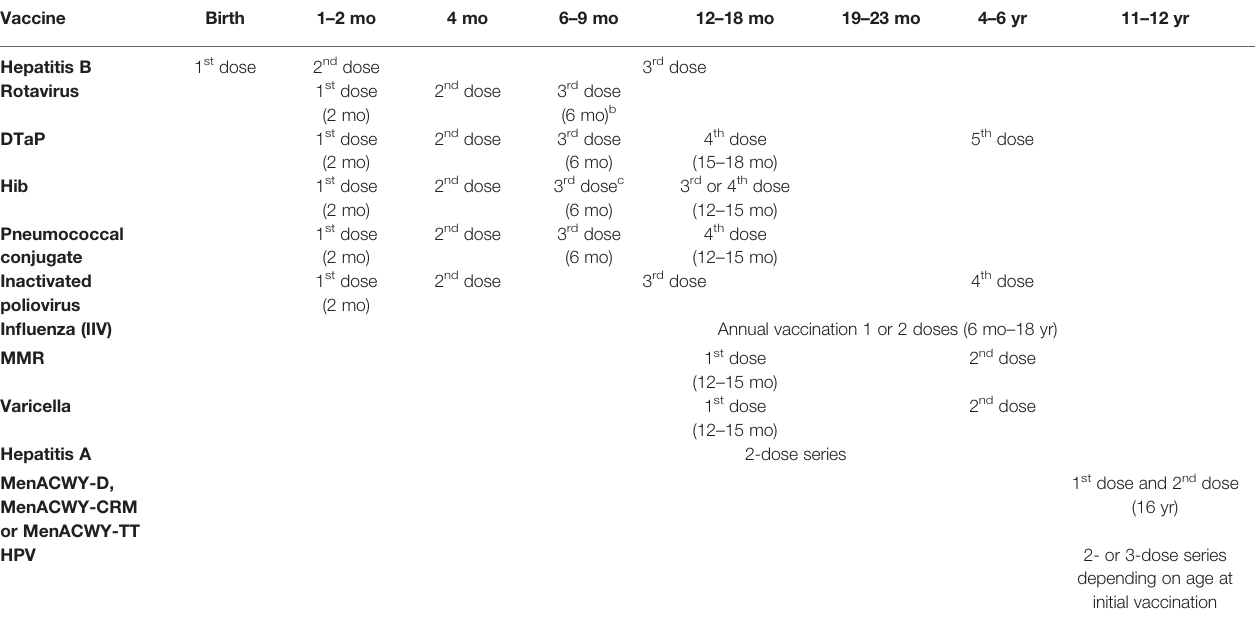
TABLE 1 | Main vaccines included in the US vaccination schedule for children aged <18 years (CDC, 2020) (56) a .